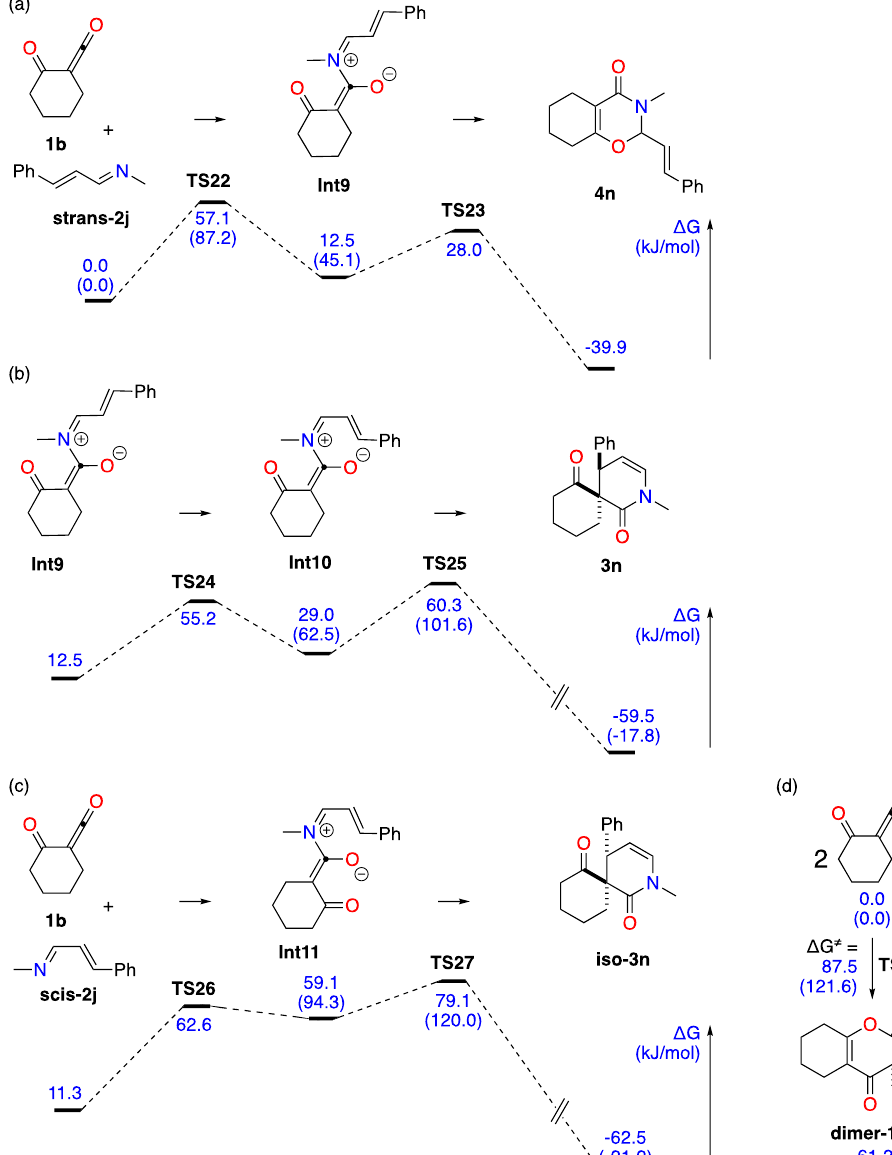
Figure 5. Free Gibbs energy profiles computed at 298 K (DFT, B3LYP-D3/6-311++G(d,p)) of the aza-Diels−Alder reactions between the α-oxoketene 1b and the 1-azadiene 2j . Free Gibbs energies noted between parentheses were computed at 473 K.